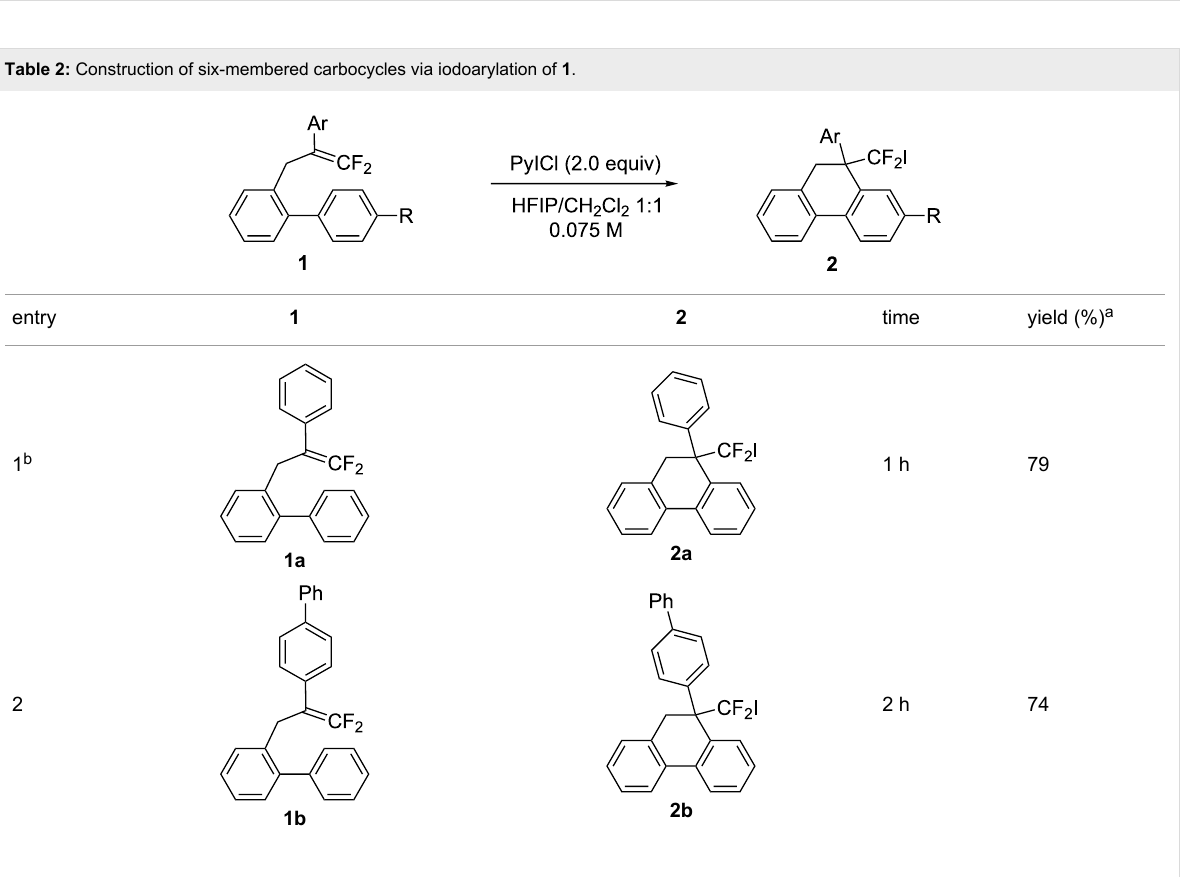
Scheme 2: Mechanism for formation of 3a .